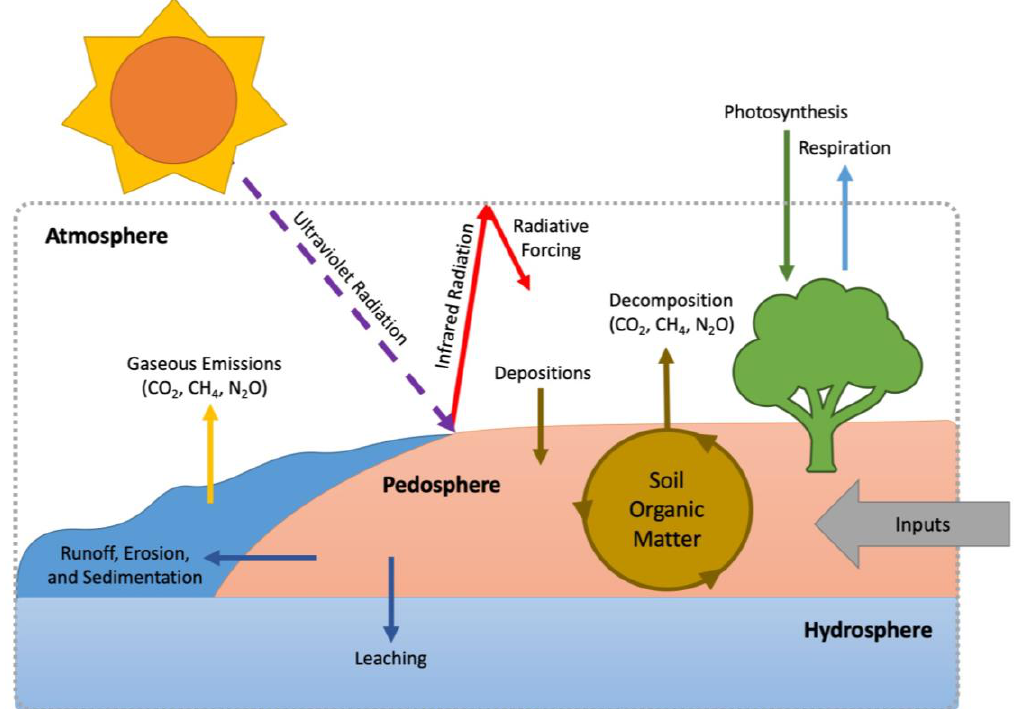
Figure 3. Cycles of energy, water, and materials cross through soil.